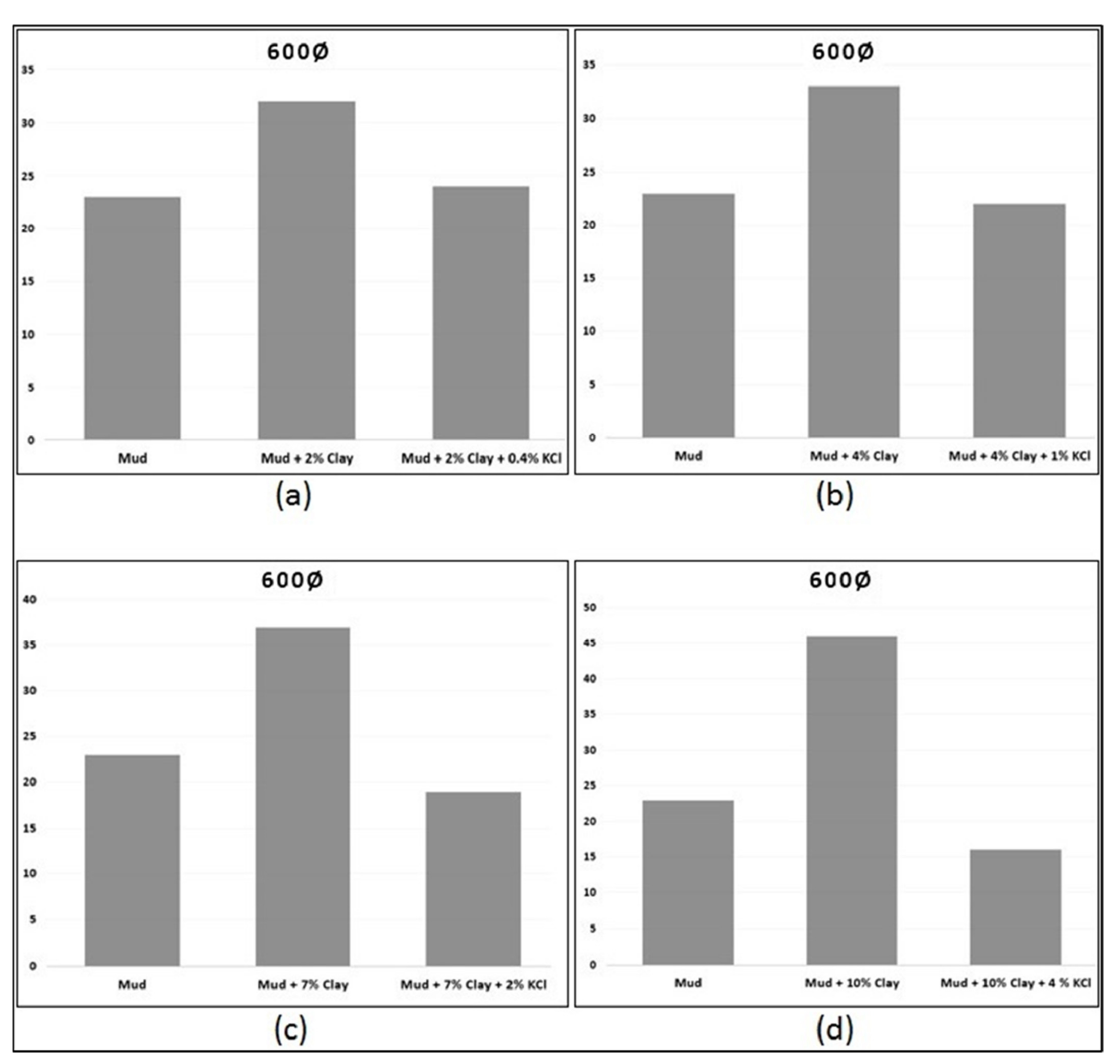
Figure 8. Bar correlation between ( a ) default mud, 2% clay-concentrated mud, and 0.4% KCL- concentrated mud + 2% clay; ( b ) default mud, 4% clay-concentrated mud, and 1% KCL-concentrated mud + 4% clay; ( c ) default mud, 7% clay-concentrated mud, and 2% KCL-concentrated mud + 7% clay; ( d ) default mud, 10% clay-concentrated mud, and 4% KCL-concentrated mud + 10%